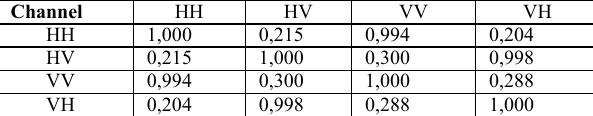
Table 6. The correlation matrix for the scene without a target. Channel